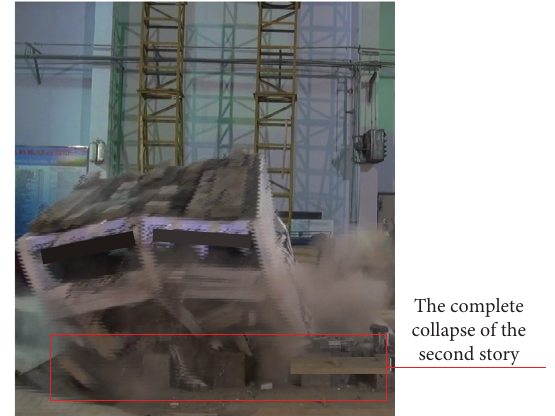
Figure 32: Second-floor collapse of the test (front).